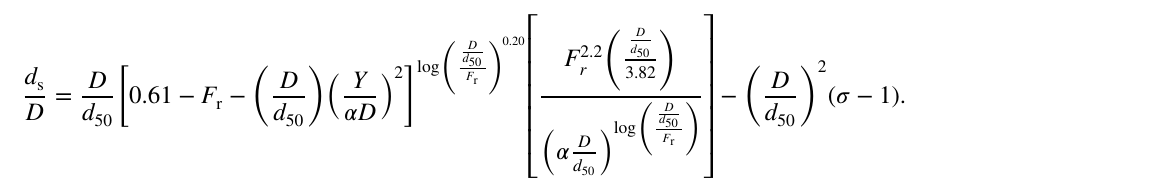
Fig. 5 ANFIS- and GP-predicted values of d (1969)